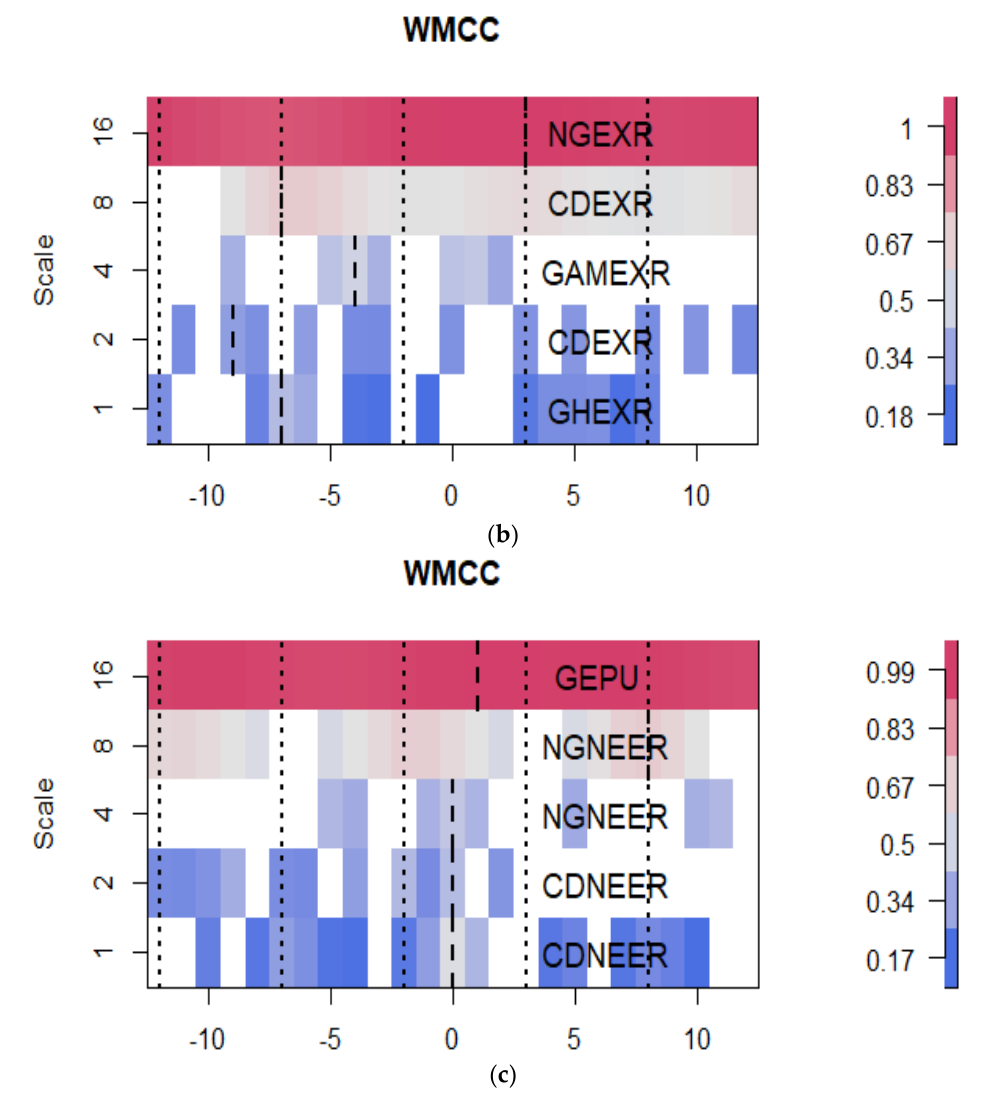
Figure 5. Wavelet multiple cross-correlation of macroeconomic variables (February 1997 to May 2019). Note: ( a – c ) represent interdependencies with CPI, EXR and NEER. Table 3. Wavelet Multiple Cross-Correlations (WMCC).